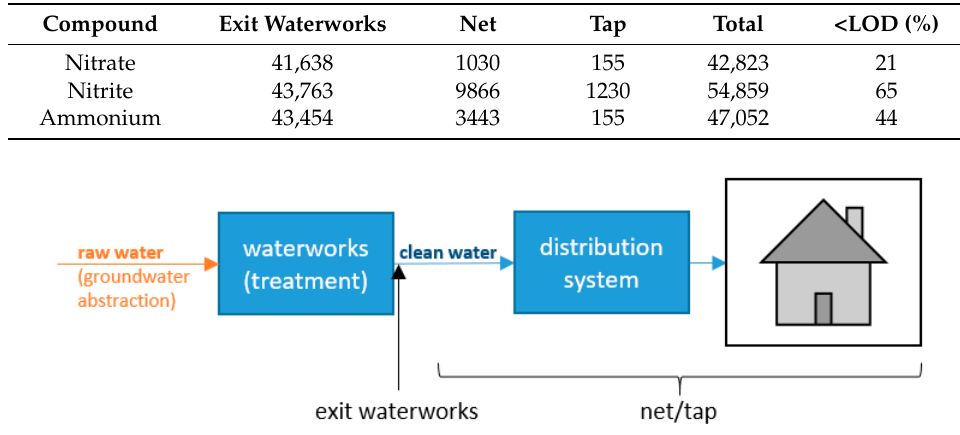
Figure 1. Schematic overview of sampling locations.